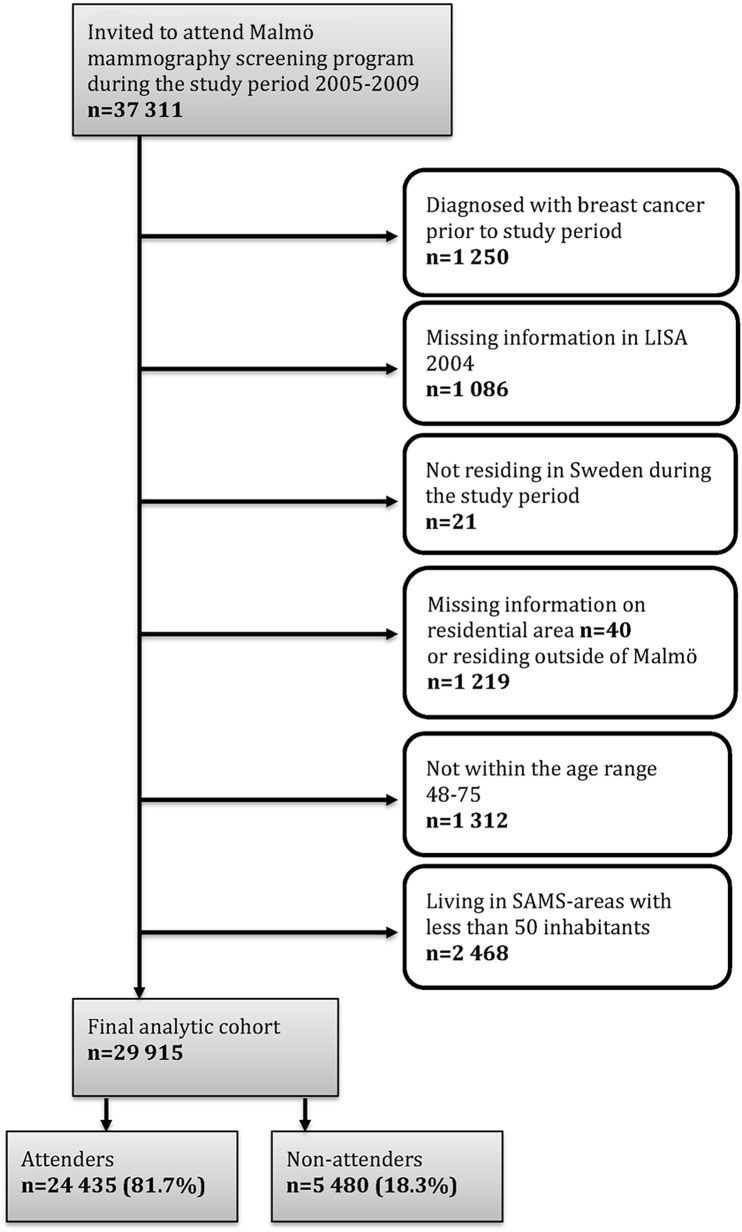
Selection of analytic cohort with stepwise exclusions.